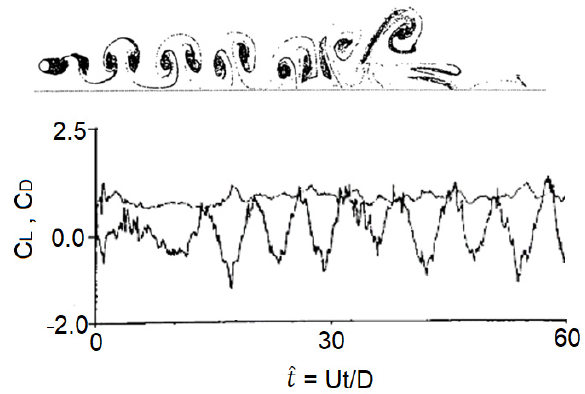
Figure 6. The flow pattern and force coefficients for G/D = 2 and Re = 100,000.